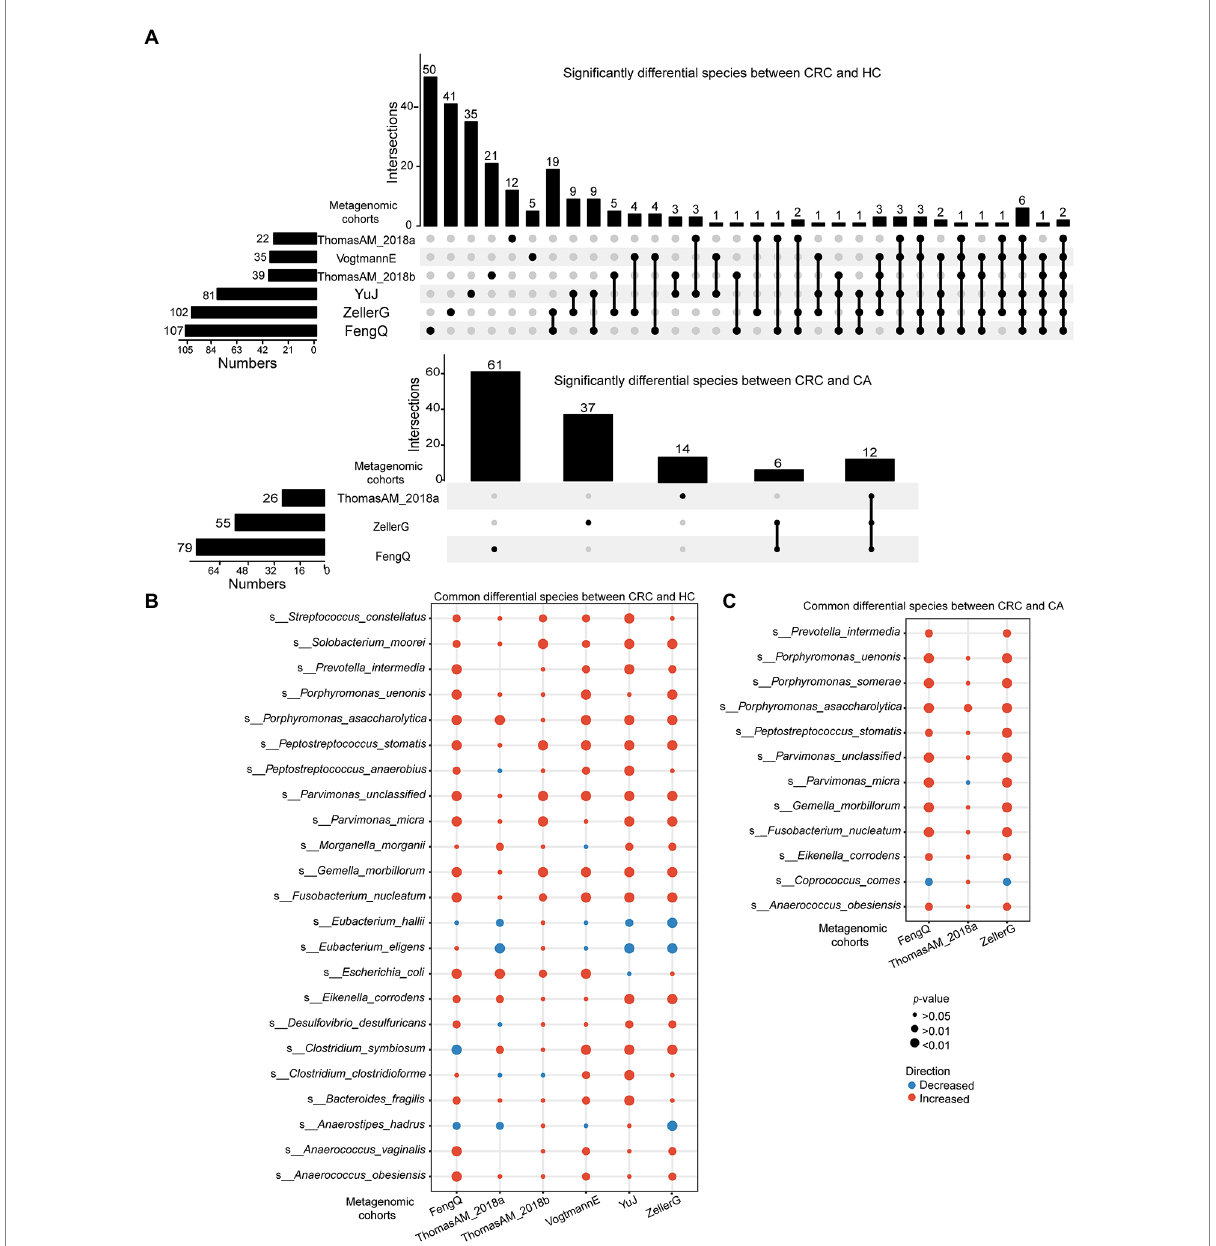
FIGURE 4 Significantly differential microbes at species level in six metagenomic sequencing datasets. (A) UpSet plot showed significantly differential species between CRC and HC or CA. (B,C) Bubble plot showed universal differential species between CRC and HC or CA. p -value was calculated by Wilcoxon rank-sum